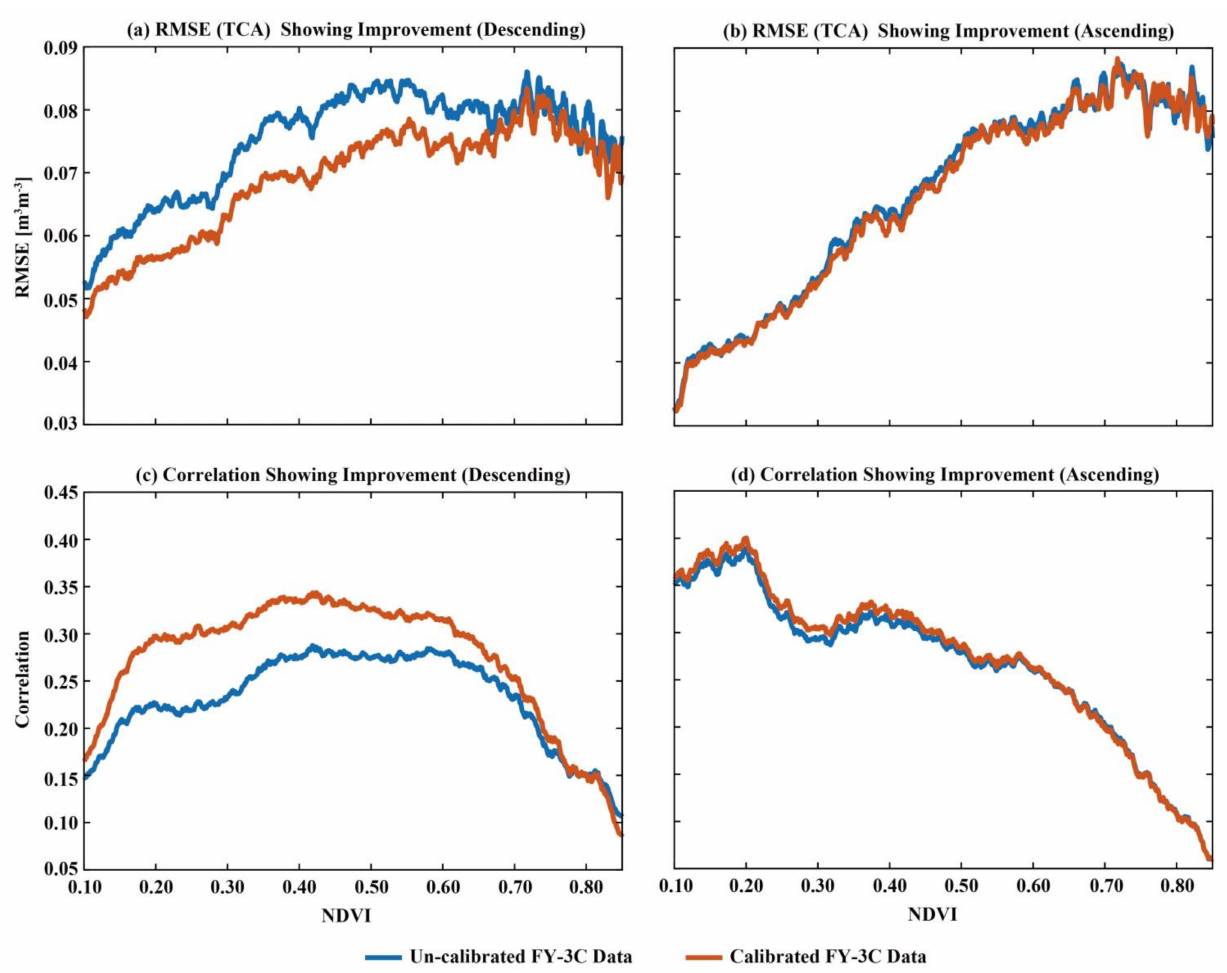
Figure 4. Showing improvements between the un-calibrated and calibrated FY-3C SM anomalies based on ( a ) RMSE by TCA for descending data (unit: m 3 m − 3 ); ( b ) RMSE by TCA for ascending data (unit: m 3 m − 3 ); ( c ) correlation for descending data; ( d ) correlation for ascending data across different NDVI scenarios. NDVI < 0.1 and NDVI > 0.85 are not included because there is no sensitivity in the satellite product due to low signal-to-noise ratio and soil moisture losing skill,